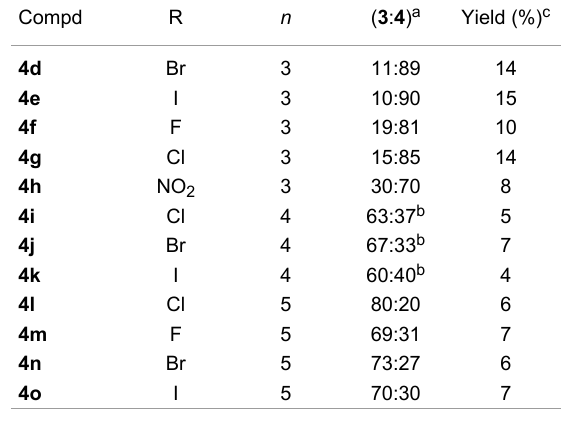
Table 2: Synthesis of thiolactone-isatin hybrids 3 and tetracycles 4